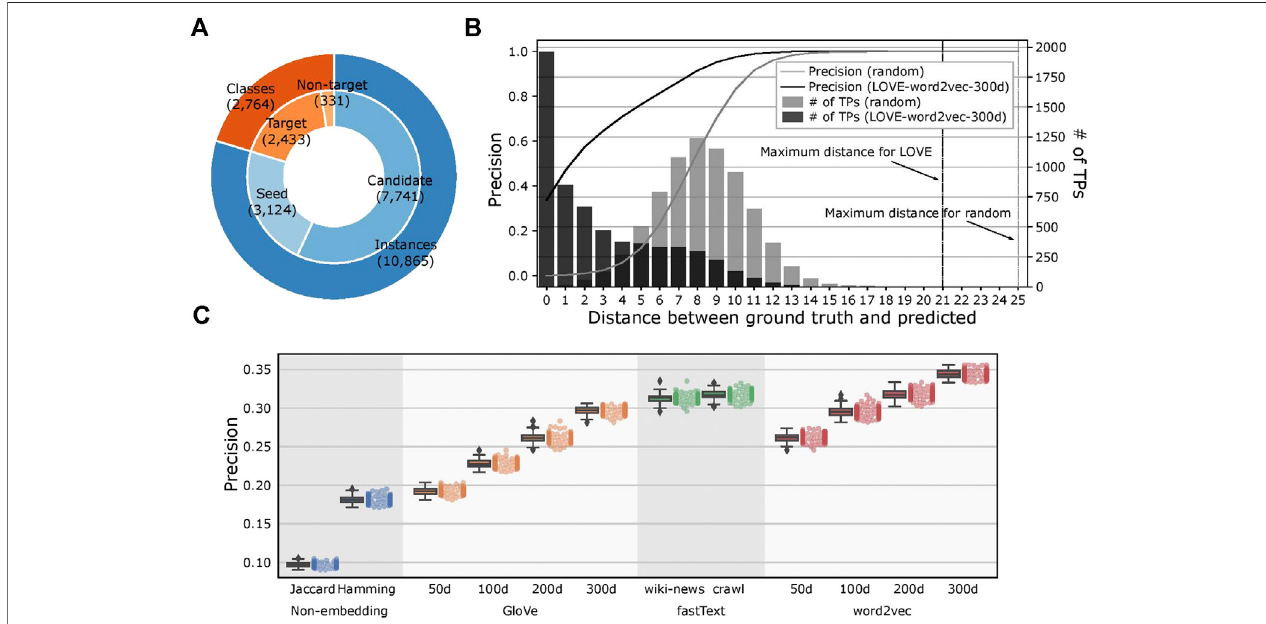
FIGURE 4 | Evaluation of the LOVE framework on a food ontology. (A) Number of ontology classes and food instances that were used for the LOVE-derived ontologies. Candidate instances are mapped to one of the target classes by LOVE, and each target class is initialized by seed instances. Classes without instances are notconsidered astargetclasses. (B) Distribution ofprecisionandnumberoftruepositivesofthemappedontologyasafunctionofshortestdistance(hops)betweenthe predicted class and the ground truth class for LOVE (black) and random assignment (gray) ( p value (cid:1) 4.8 × 10 − 102 ). (C) Precision of the ontology population for different similarity